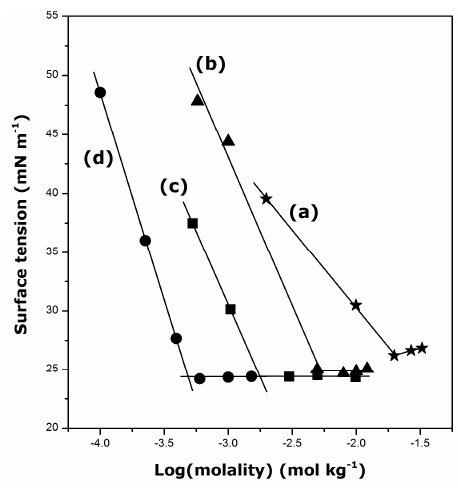
Figure 3. Plots of the surface tension against logarithm of the bulk molality for aqueous solutions of guanidinium cationic surfactants: (a) DGC at 298 K; (b) DDGC at 298 K; (c) TDGC at 306 K; and (d) CGC at 317 K.